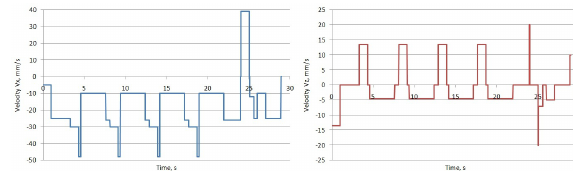
Figure 4: Variations in the axial (V x ) and radial (V z ) velocities of